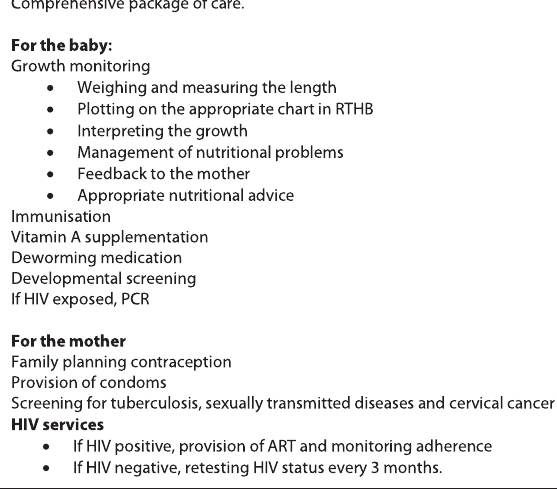
Figure 1: Services included in the comprehensive package of